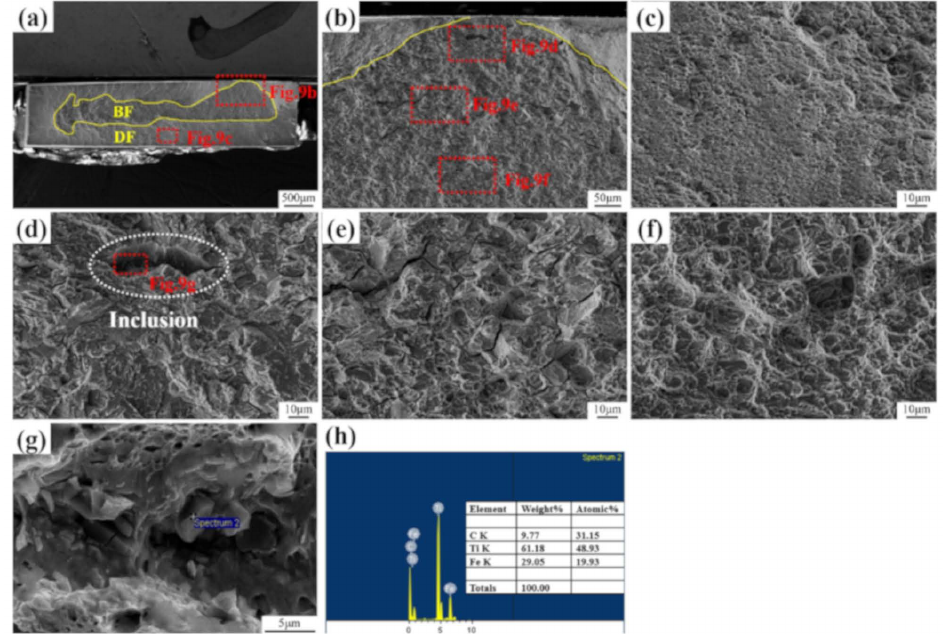
Figure 9. SEM images of fracture surface of specimens with 1 h pre-charging time and strain rate 1 × 10 − 3 s − 1 . ( a ) Entire image of the fracture surface; Magnified images of the parts surrounded by red dotted lines in ( b ) and ( c ), and further magnified, in ( d ), ( e ), and ( f ), from ( b ). The yellow solid lines indicate the boundaries between the brittle fractured region (BF) and the ductile fractured region (DF). The white dotted line in ( d ) indicates the hole left by the shedding of inclusions, ( g ) Magnified images of the part surrounded by red dotted line in ( d ). ( h ) Energy spectrum analysis (EDS) analysis result of inclusions at the bottom of the hole shown in ( g